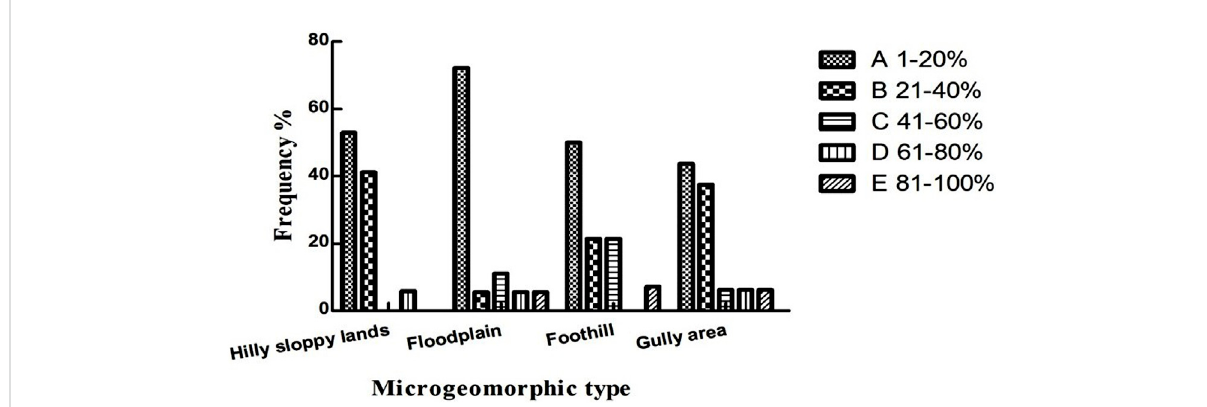
FIGURE 2 The distribution of standard frequency of species referring to the Raunkiaer ’ s law.